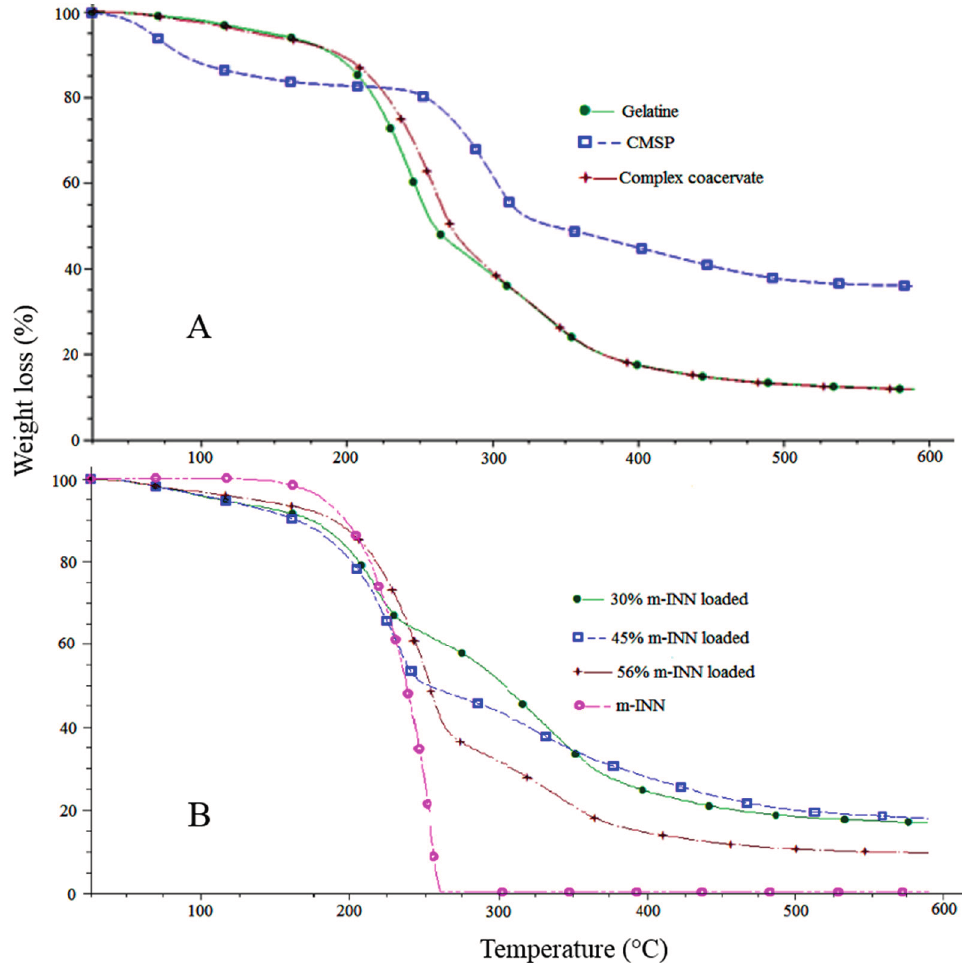
Figure 5. ( A ) TGA of gelatine, CMSP and unloaded complex coacervates; and ( B ) TGA of micronized ibuprofen, 30, 45 and 56% w / w drug loaded